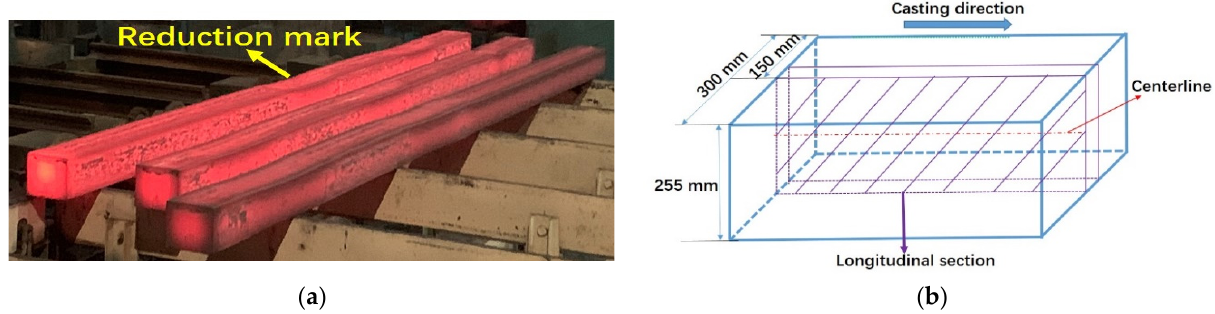
Figure 2. Reduction marks on bloom ( a ) and the bloom sampling plan for steel GCr15 ( b ).